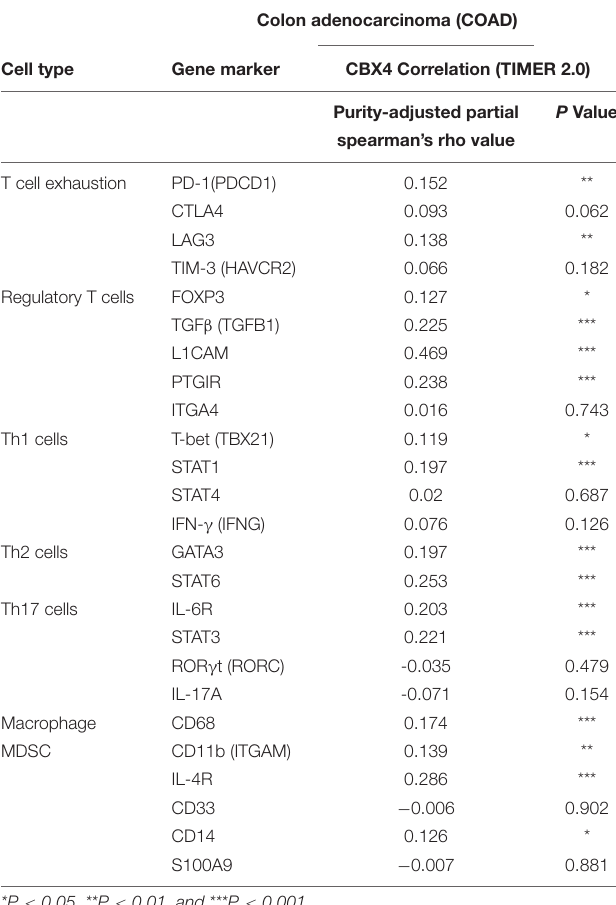
TABLE 1 | Correlations between CBX4 and gene representatives of various functional cell subsets in COAD determined by